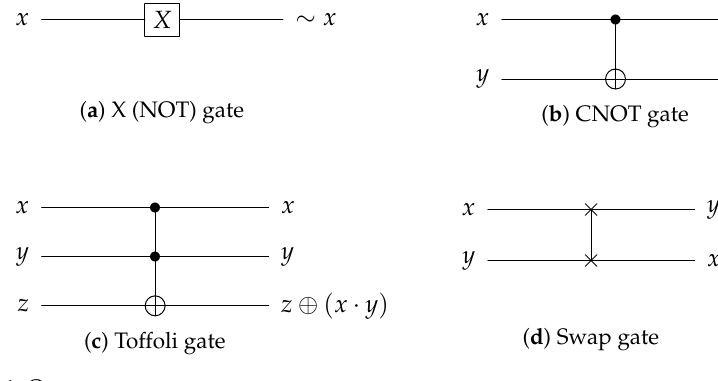
Figure 1. Quantum